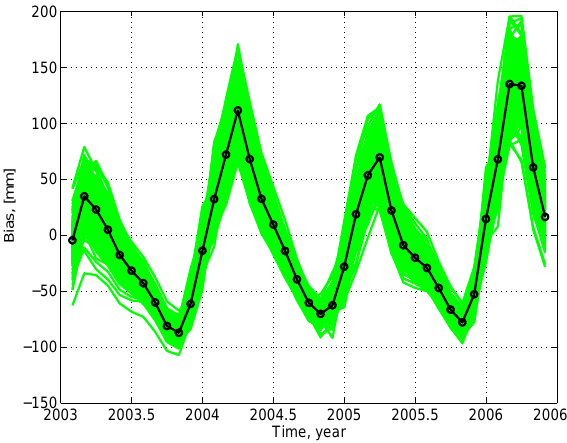
Fig. 7. Time variable bias (in green) averaged over the upper Zam- bezi target area from a Monte Carlo simulation (200 realizations, 30% noise in rainfall numbers). Mean bias is given in